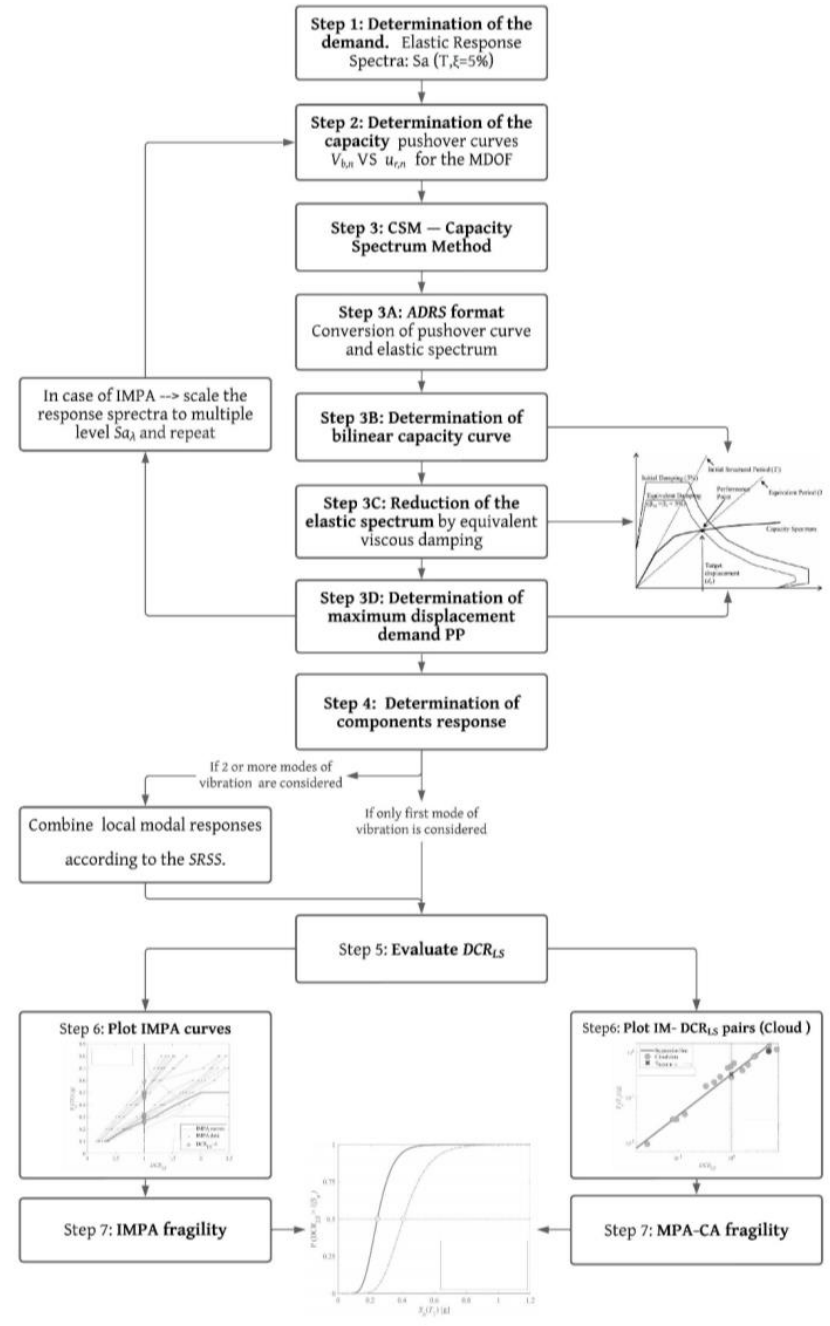
Figure 3. Flowchart of MPA-CA and IMPA procedures. V b,n and u r,n are the base shear and the top displacement respectively, PP is the performance point and DCR LS is the critical demand to the capacity ratio for the desired limit state ( LS